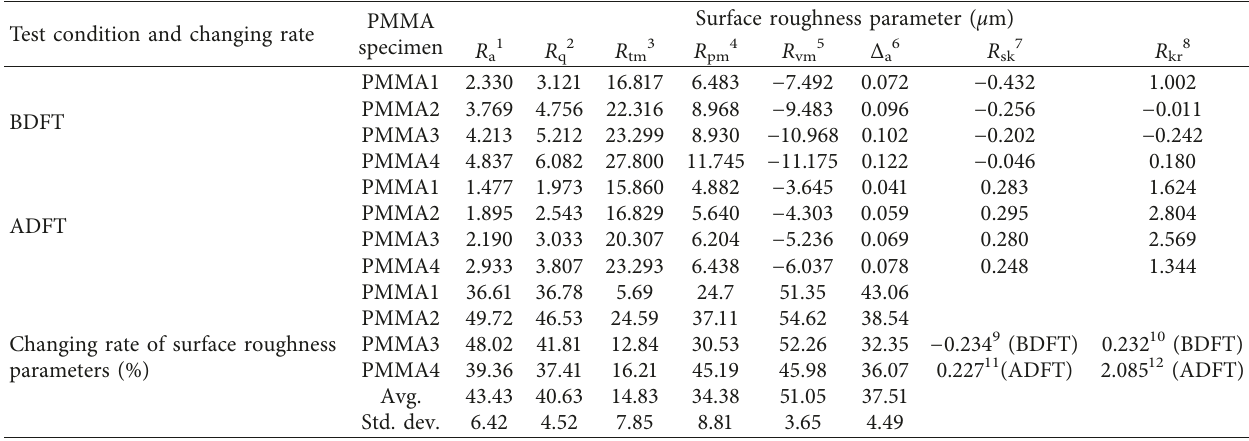
Figure 2: The photographic image of the laser scanning confocal microscope (LSCM, Bio-Rad MRC-600) used for this Table 1: Measurement results of the surface roughness parameters for the PMMA specimens before (BDFT) and after the dynamic friction tests (ADFT).